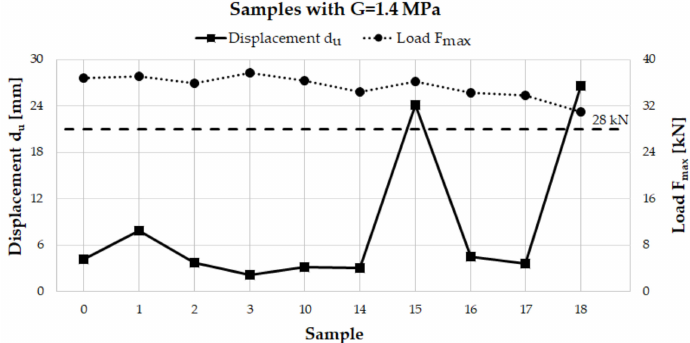
Figure 7. Test results in terms of displacements and loads for samples with G = 1.4 MPa.